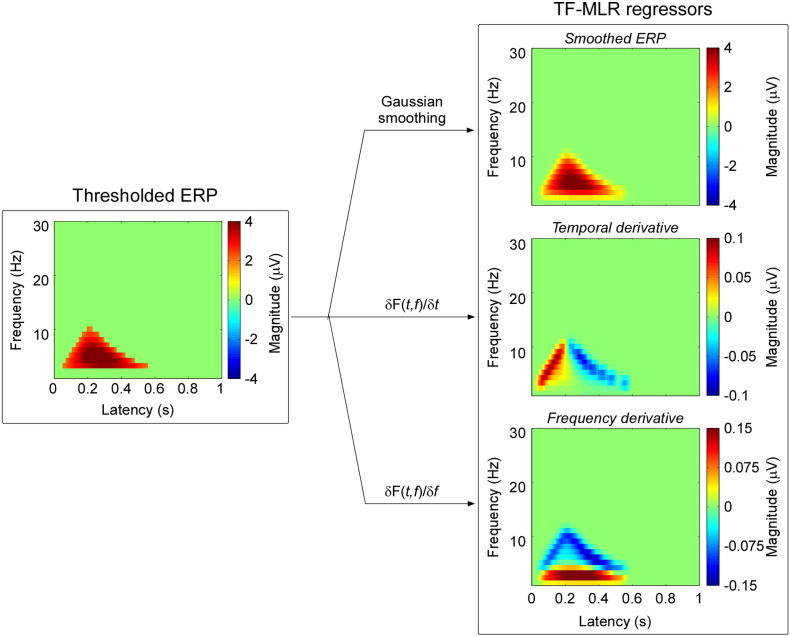
Generation of regressors in the TF-MLR approach.Left panel: Time-frequency representation of one of the thresholded features (‘ERP’, in this example) of the EEG response, obtained by PCA decomposition with Varimax rotation (Fig. 1). Right Panel: The three regressors obtained by the TF-MLR approach represent the average (Gaussian smoothing; the spread parameters of the Gaussian kernel are: σx = 30 ms, σy = 3 Hz), the temporal derivative and the frequency derivative of the ERP response, respectively. The temporal and frequency derivatives will be used to capture the variability in latency and frequency of single-trial TFDs.